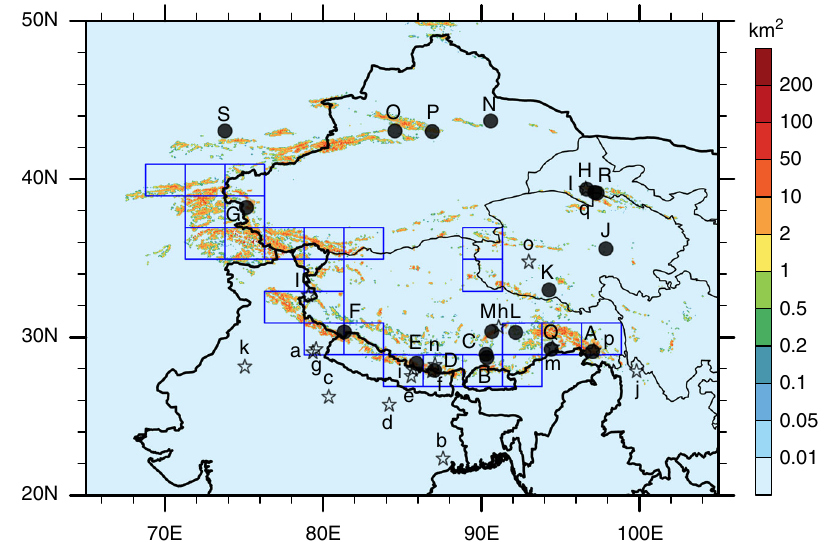
Fig. 1 The spatial distribution of glacier areas over the HTP and adjacent regions. The rectangles denote the selected HTP glacier regions de fi ned as receptors in the adjoint simulation, where the glacier area in each grid exceeds 2% based on the World Glacier Inventory (WGI) 53 . Black pentagrams are 17 measurement sites of the surface BC concentrations: Nainital (b), Kharagpur (b), Kanpur (c), Gandhi College (d), Nagarkot (e), Langtang (f), Nepal Climate Observatory at Pyramid (NCOP) (g), Manora Peak (h), Nam Co Observational Station (NCOS) (i), Zhuzhang (j), Muztagh Ata (k), Hanle (l), Lutang (m), QOMS (n), Beiluhe (o), Ranwu (p), and QSSGEE (q). Black circles are 20 measurement sites of BC concentrations in the snow: Zuoqiupu (A), Qiangyong (B), Noijin Kangsang (C), East Rongbuk (D), Kangwure (E), Namunani (F), Mt. Muztagh (G), Laohugou #12 (H), Qiyi (I), 1 July glacier(J), Meikuang (K), Dongkemadi (L), La ’ nong (M), Zhadang (N), Haxilegen River (O), Urumqi Riverhead and Tianshan Urumpi glacier #1 (P), Miao ’ ergou #3 (Q), Demula glacier (R), and Muji glacier (S). Please see the Supplementary Tables 2 and 3 for additional details